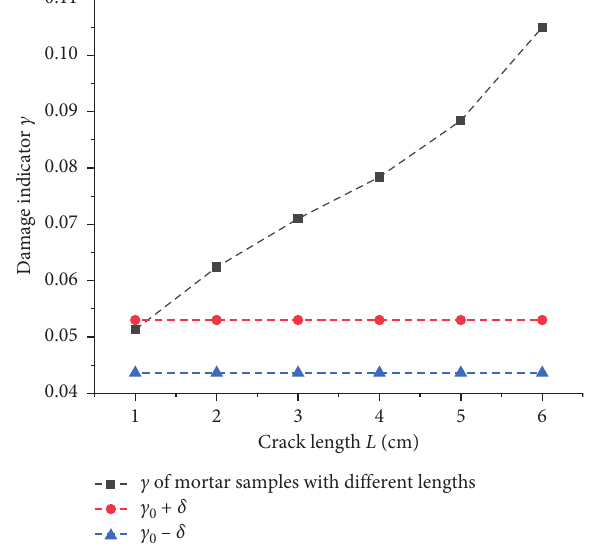
Figure 18: Damage indicator c in specimens L1 ∼ L3.